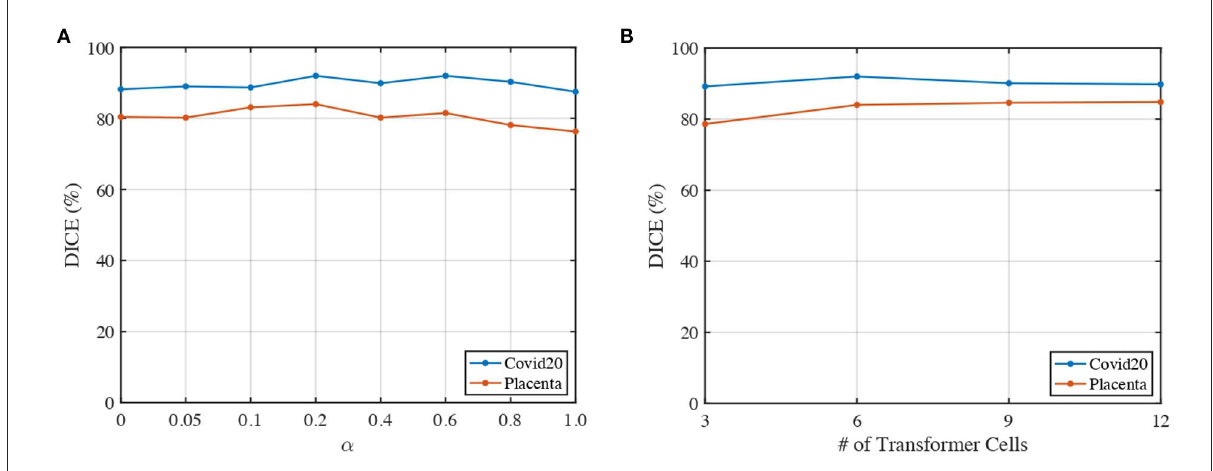
FIGURE6 Impacts of α and number of transformer cells on segmentation performance. (A) Dice of 3DTU vs. α . (B) Dice of 3DTU vs. number of transformer